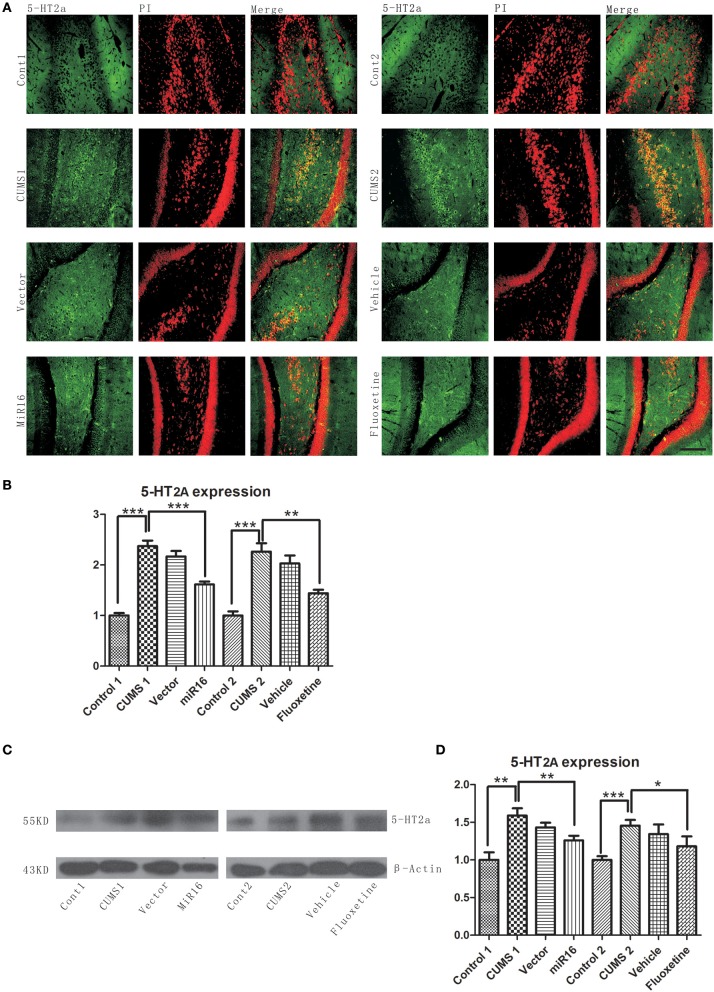
5-HT2a upregulation after CUMS was observed from Western blot and immunofluorescence staining. Representative images of 5-HT2a by immunofluorescence staining (A) are in accordance with western blot (C) analysis of protein levels of 5-HT2a and β-actin in the rat hippocampus of each group. (B) The histogram from 5-HT2a staining showed that CUMS groups are increased compared to the control, whereas miR-16 and Fluoxetine treatment groups attenuated this increasing tendency. Values are the means ± SEMs. *P < 0.05; **P < 0.001; ***P < 0.0001. (D) Optical densities of respective protein bands (C) were analyzed and normalized to β-actin. Results were expressed as means ± SDs from three independent experiments. From the histogram, the expression of 5-HT2a in each group has a comparatively similar fluctuation to immunochemistry staining.